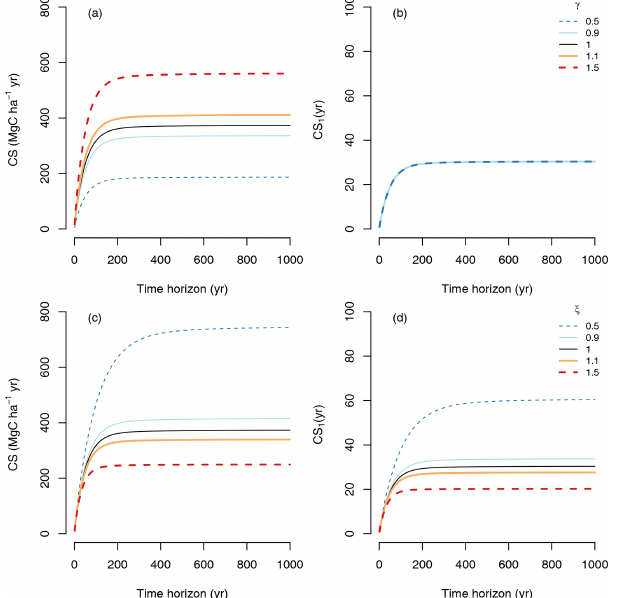
Figure 8. Effects of different management strategies on CBS. (a) Effect of increasing or decreasing carbon inputs by a proportion γ on CBS; (b) same effect of γ expressed as a ratio with respect to the reference case of γ = 1. (c) Effects of decreasing or increasing process rates in the matrix B by a proportion ξ on CBS; (d) same effect of ξ expressed as a ratio with respect to the reference case ξ =